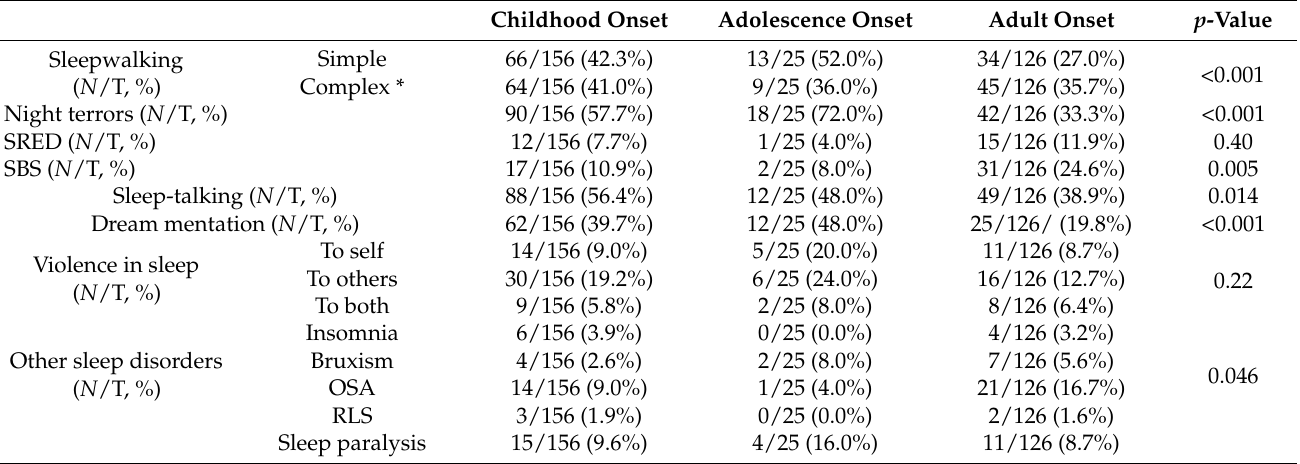
Table 3. NREM parasomnia subtype and other sleep disorders split by age of onset ( p at 0.05/3 =